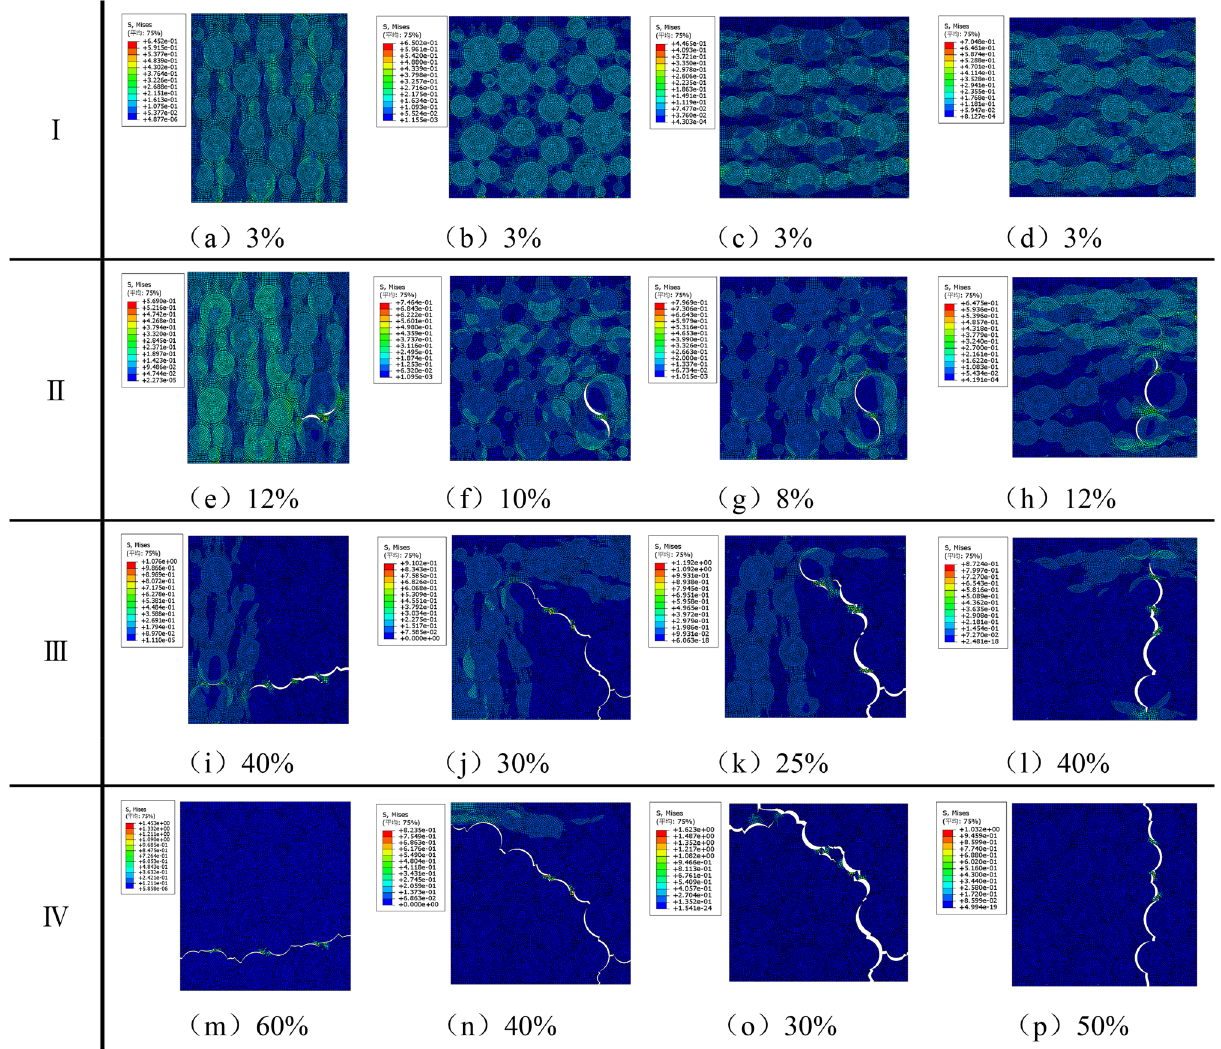
Figure 18. Stress nephograms of damage evolution under different loading conditions under 0.05 s −1 strain rate loading (I-Initial linear stage, II-Start-dewetting point, III-Damage evolution stage, IV-Fracture failure stage; a-Uniaxial tension, b-1:1 Biaxial tension, c-1:2 Biaxial tension, d-1: 4 Biaxial